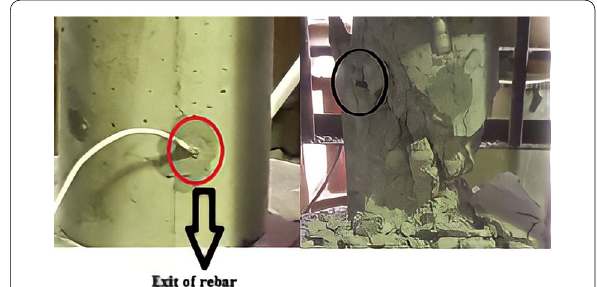
Fig. 5 Rebar sliding and exit in the C14.77D8L3.5-2 specimen.